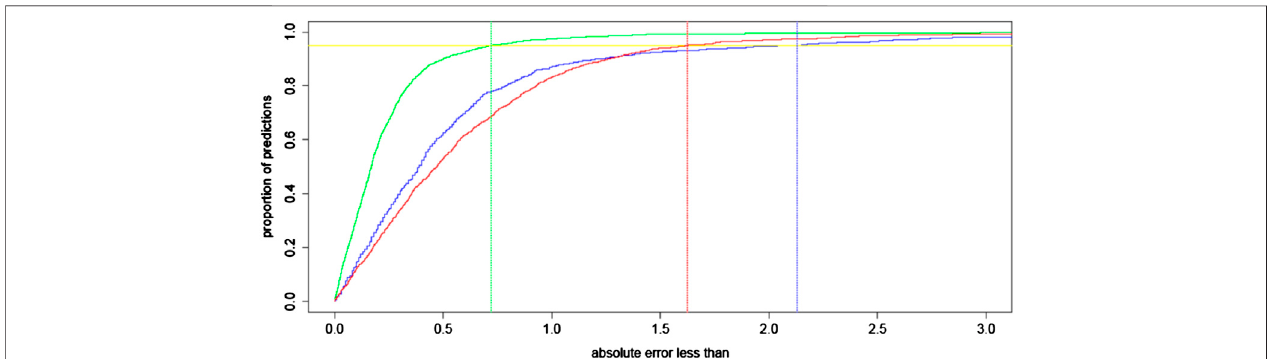
FIGURE2| Aregressionerrorcharacteristiccurvefortheabsoluteerrorofintraocularlens(IOL)power(inD)forBART(green),theRBF1.0calculator(blue),andthe SRK/T formula (red) for 1,000 eyes out-of-sample. To interpret this illustration, consider the example of eyes with 0.5 D or less absolute error in their predictions for IOL power. Approximately 90% of BART ’ s predictions have this level of precision, while approximately 60% of the RBF 1.0 calculator ’ s predictions and 55% of predictions with the SRK/T formula have such precision. The vertical lines represent the maximum absolute error for 95% of predictions in all three compared approaches.